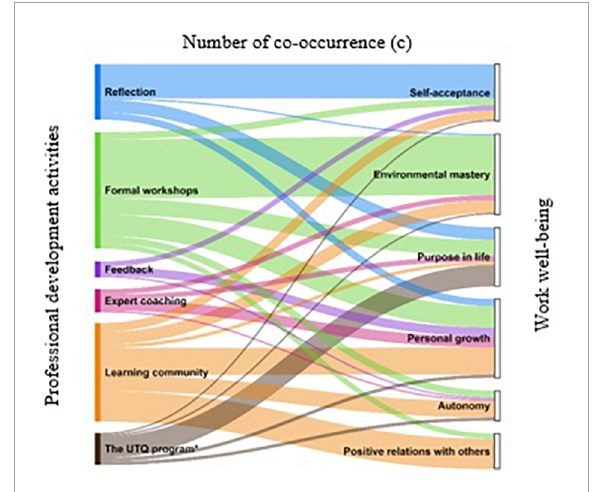
FIGURE2 Sankey diagram of the number of co-occurrences. *The UTQ program contains all other professional development activities (reflection, formal workshops, feedback, expert coaching, and the learning